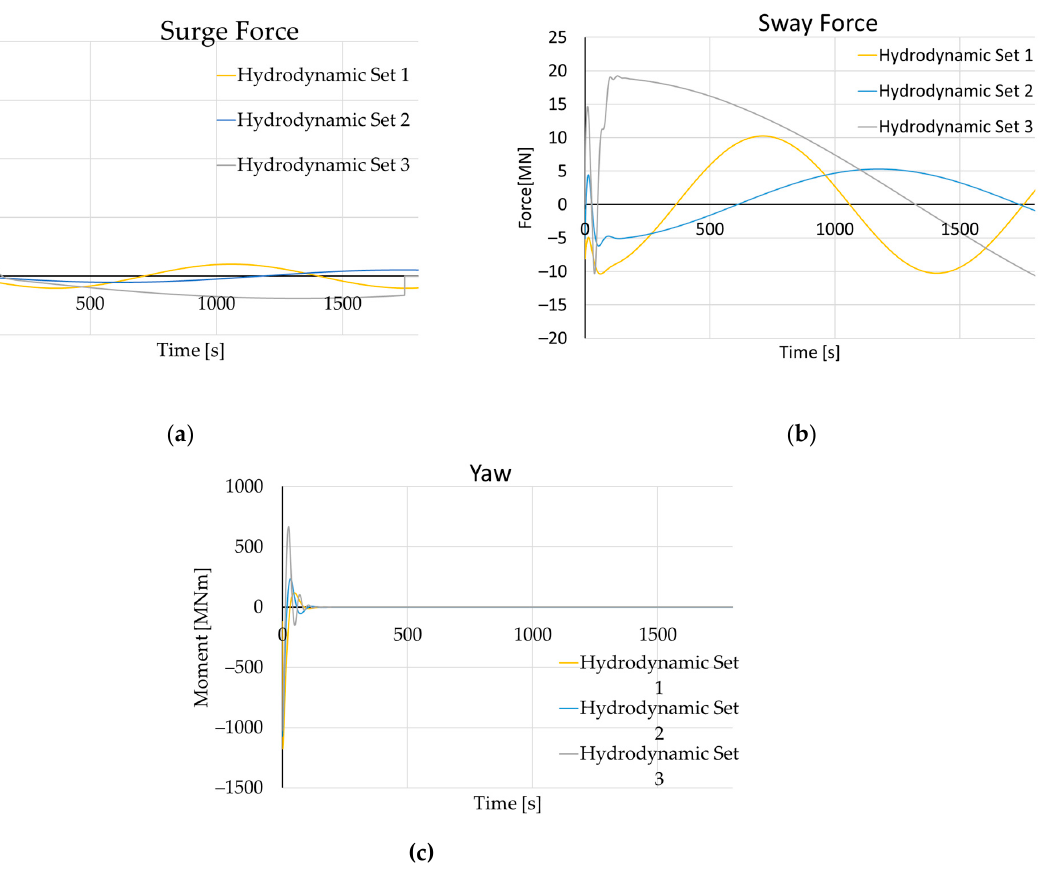
Figure 8. Turning circle test: Normalised displacement over a ship length in global CS.